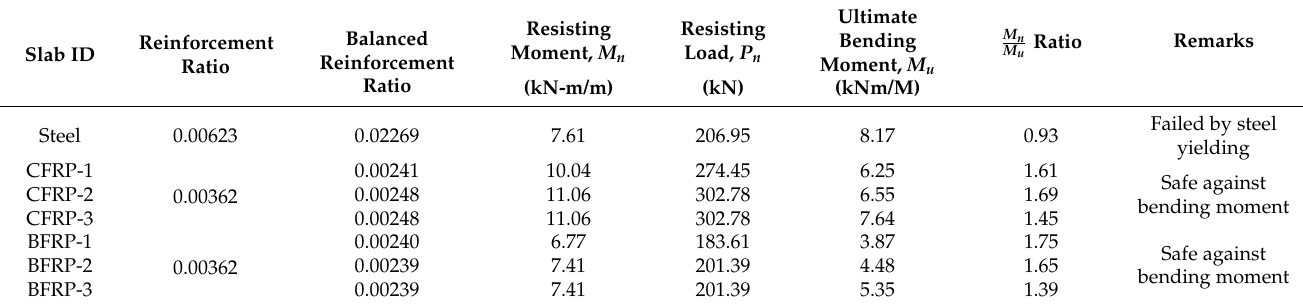
Table 8. Ultimate resisting moment and bending moment of the slabs.